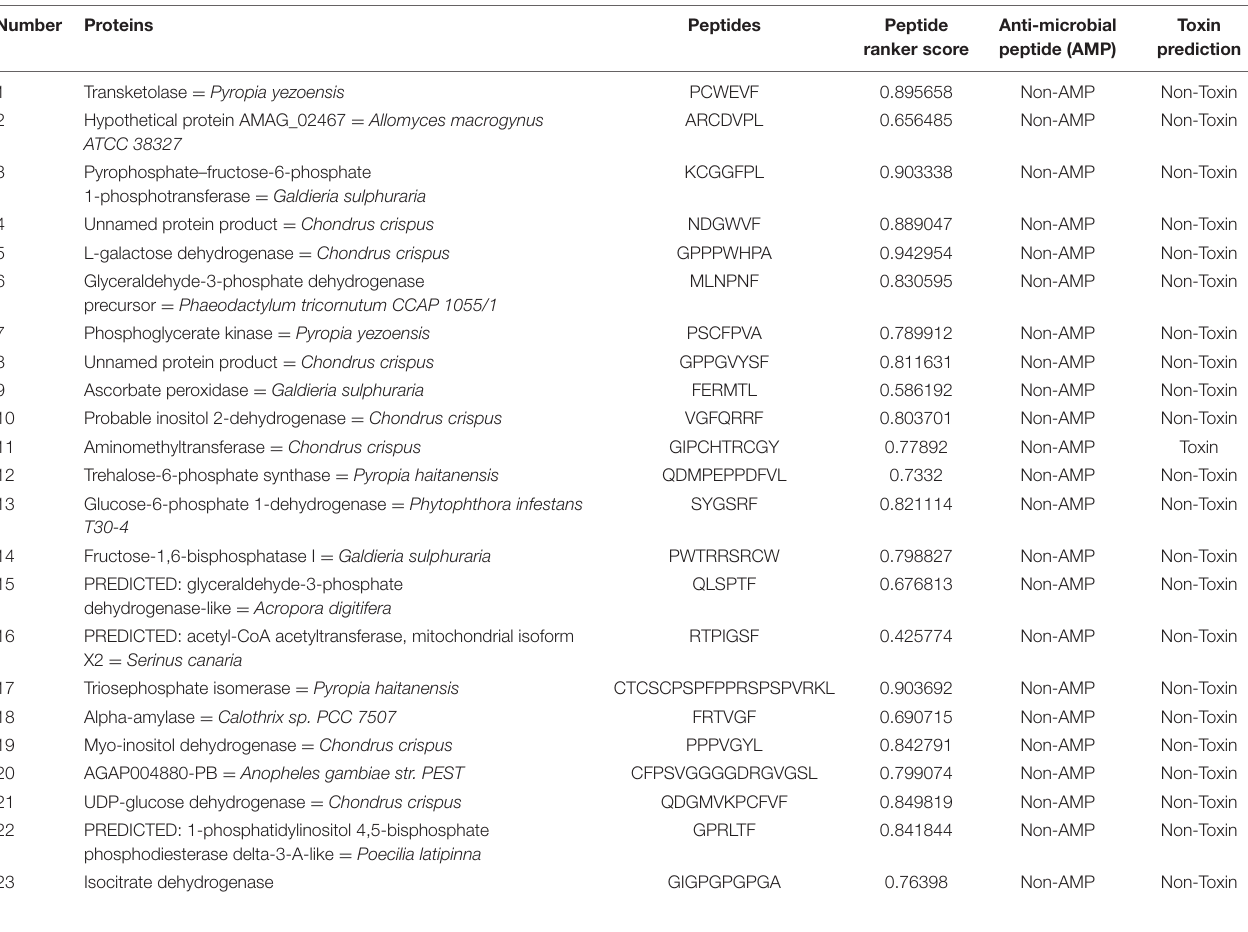
TABLE 4 | Selected potential bioactive peptides of the carbohydrate metabolism proteome predicted by in silico digestions with pepsin. Number Proteins